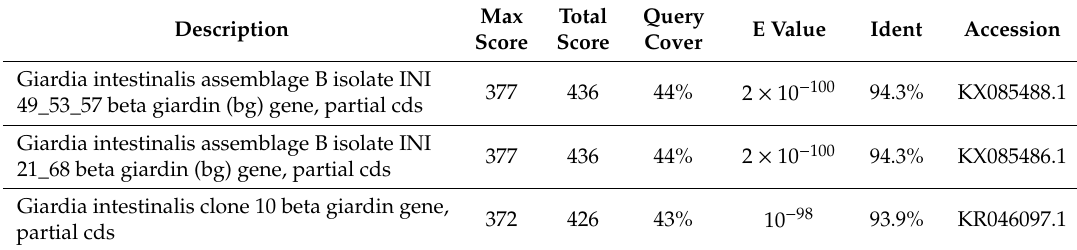
Table A2. BLASTn results for the sequences obtained by PCR amplification of the G. intestinalis β -giardin gene (Primer